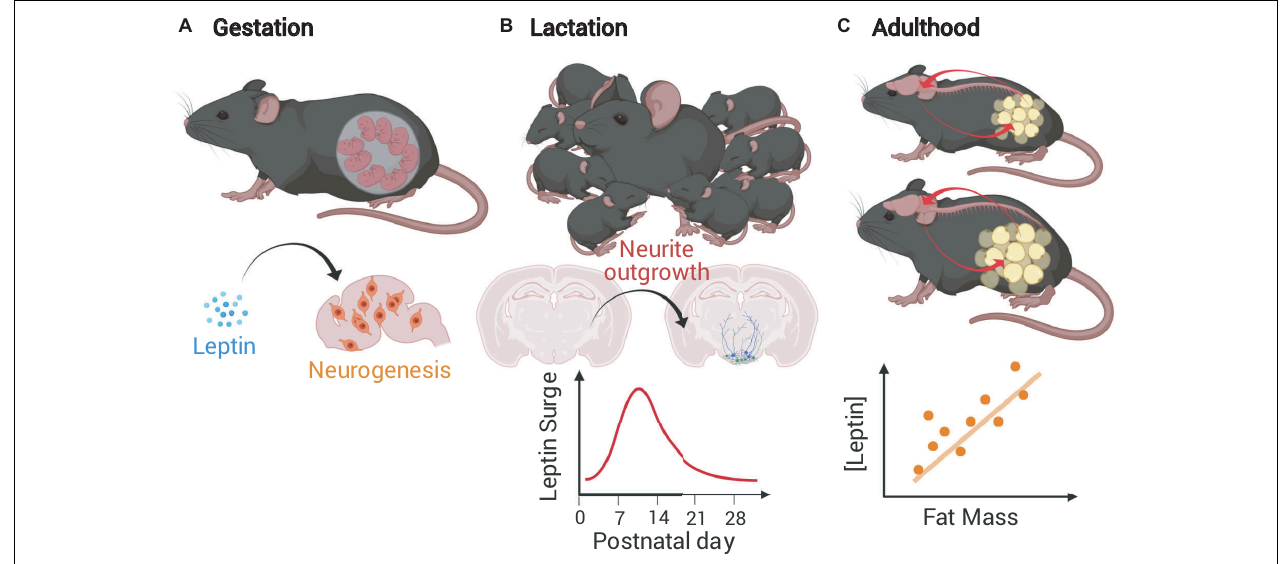
FIGURE 1 | Leptin functions in mice during gestation, lactation, and adulthood. (A) In the gestational period, leptin mediates neurogenesis and proliferation of other brain cells (not limited to gestation). (B) During the immediate postnatal (lactational) period, mice undergo a leptin surge that is critical for the outgrowth of projections from feeding circuit essential neurons. (C) In adult mice, leptin is produced in rough proportion to stable fat mass, informs the CNS about energy stores, and protects against fat loss (Figure created with